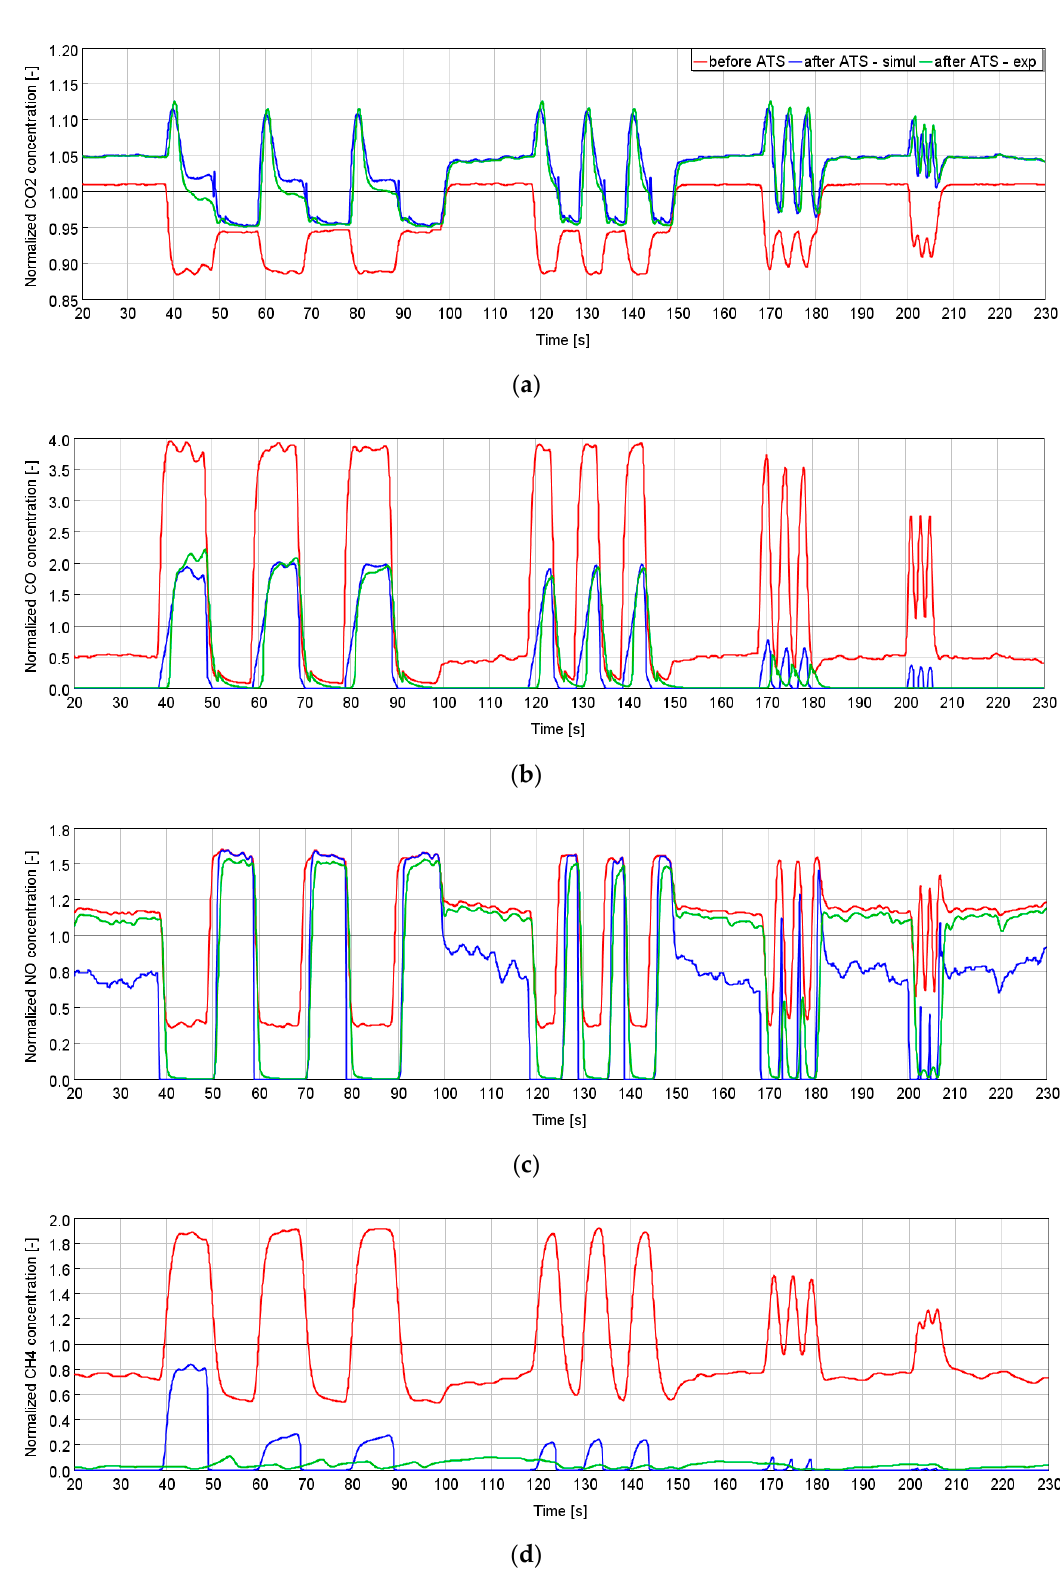
Figure 11. Transient conditions at 80% Load. Gas Temperature ≈ 740 °C ( a ) Num/Exp. CO 2 engine out and tailpipe concentration. ( b ) Num/Exp. CO engine out and tailpipe concentration. ( c ) Num/Exp. NO engine out and tailpipe concentration ( d ) Num/Exp. CH 4 engine out and tailpipe concentration.